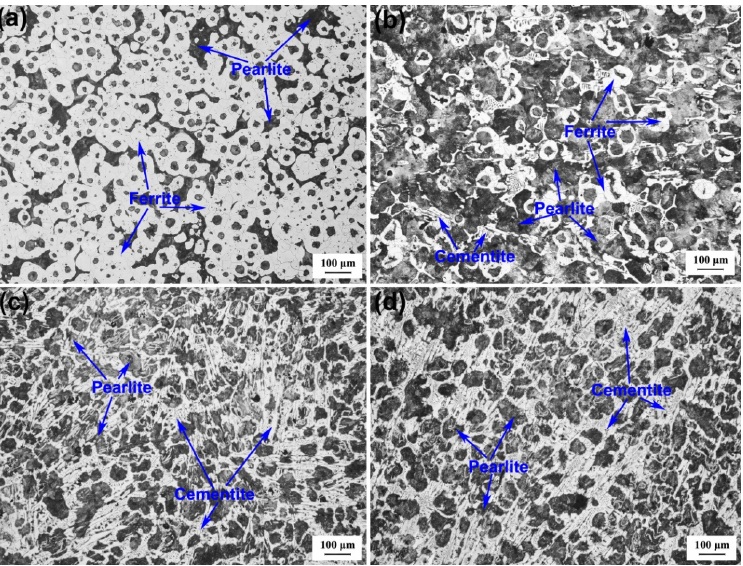
Figure 8. Microstructure of DI after injecting nitrogen gas for di ff erent time periods: ( a ) 0 min; ( b ) 20 min; ( c ) 40 min; ( d ) 60